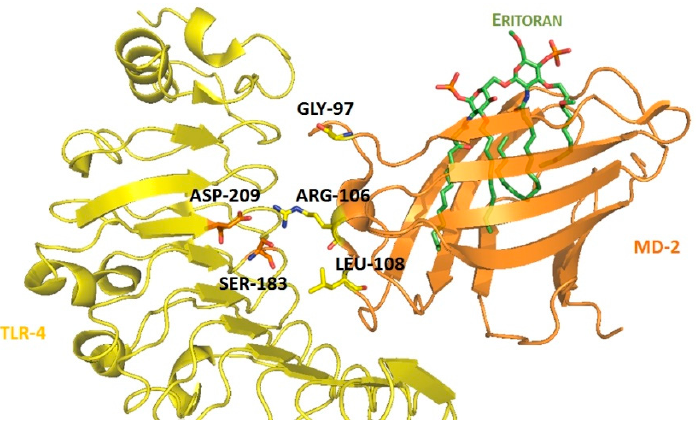
Figure 4. 3D structure representation of the extracellular domain of the TLR4/MD-2 complex with Eritoran (PDB-ID: 2Z65) focused on the interaction surfaces between TLR4 ( yellow ), and MD-2 ( orange ). Polar amino-acid residues used to perform the docking procedure are shown in sticks .